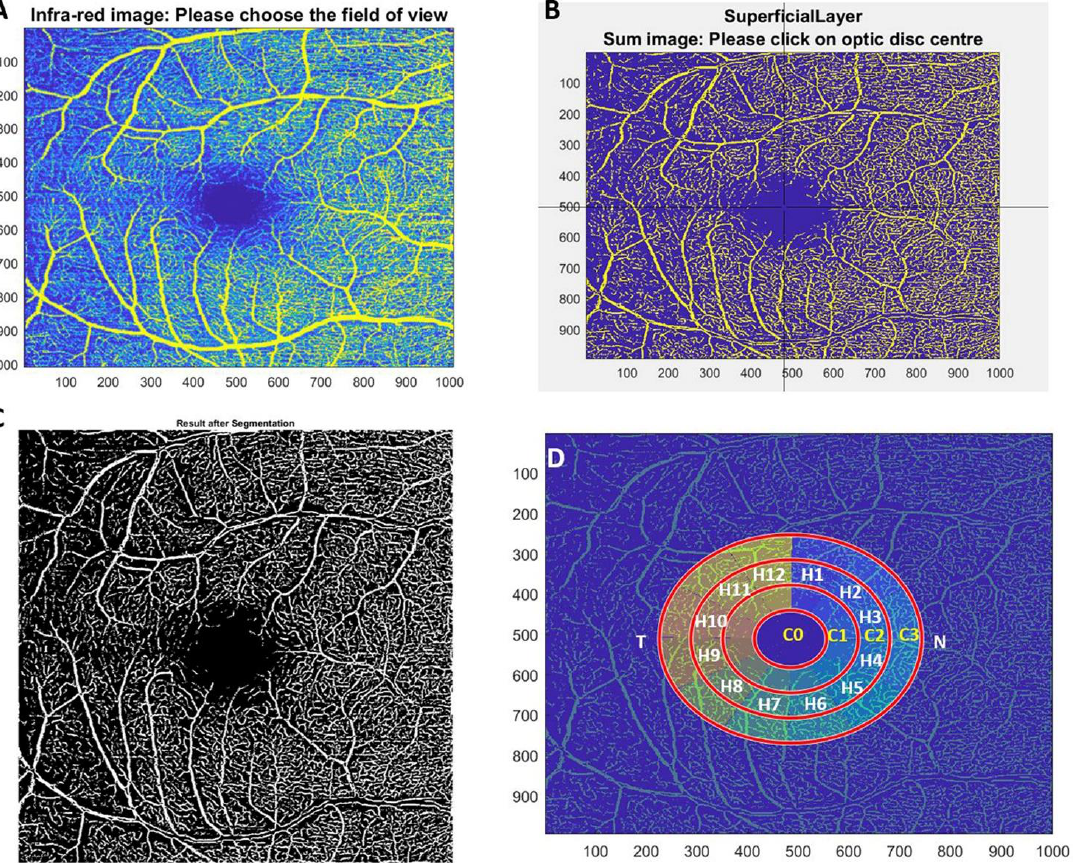
Figure 4. The analysis of vascular density using Erlangen-Angio-Tool software. ( A ) An infrared image where the user must delimit the analysis area. ( B ) The manual selection of the macula or optic nerve center, which is marked by a geometric grid and manually confirmed by a crosshair. ( C ) The resulting image after segmentation. ( D ) The segmentation into concentric rings and hourly sectors in which the analysis of the percentage of vascular density is performed.